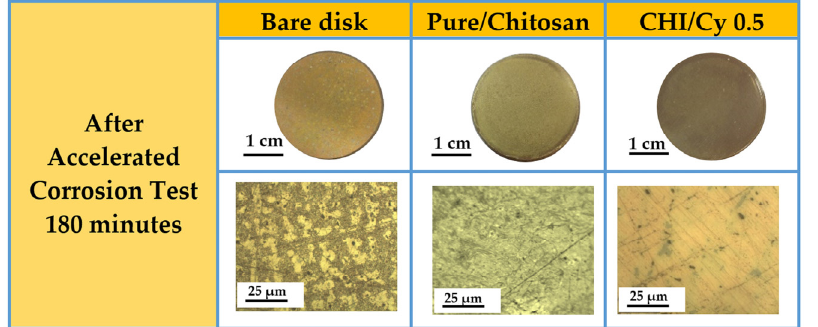
Figure 3. General appearance and OM micrographs of the Cu-based alloy, Cu-based alloy coated with a thin chitosan film without inhibitor and with inhibitor at concentration of cysteine: 0.5 mg/mL after accelerated corrosion test (180 min). For all samples the scale bar corresponds to 25 μ m. As shown, CHI-Cy 0.5 films maintain their homogeneity after the corrosion test. Opti-